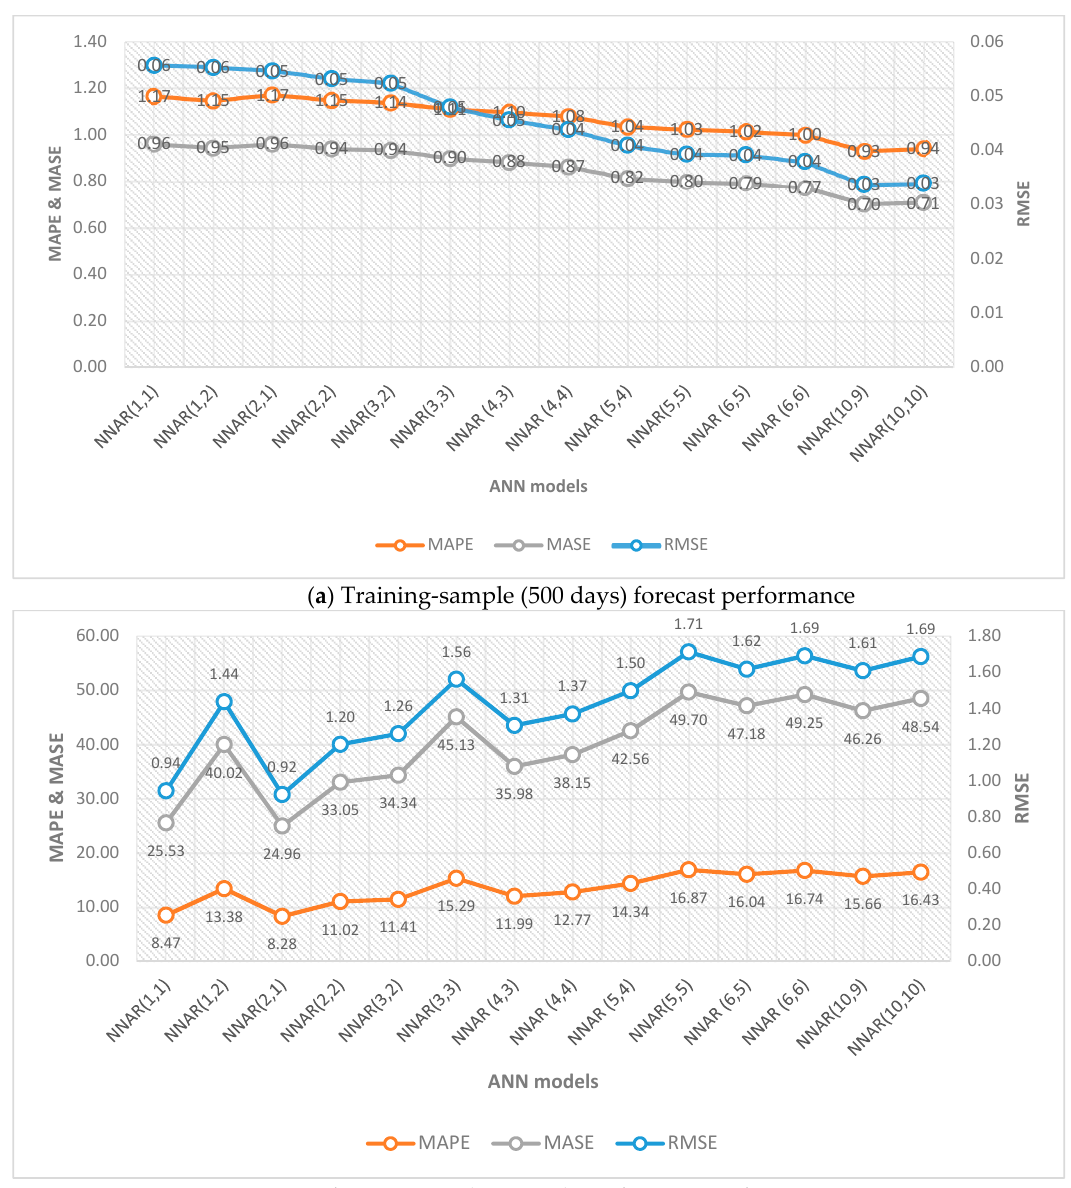
Figure A1. Examined NNAR model performance. ( a , b ) The first training and test-sample forecast performance, respectively.